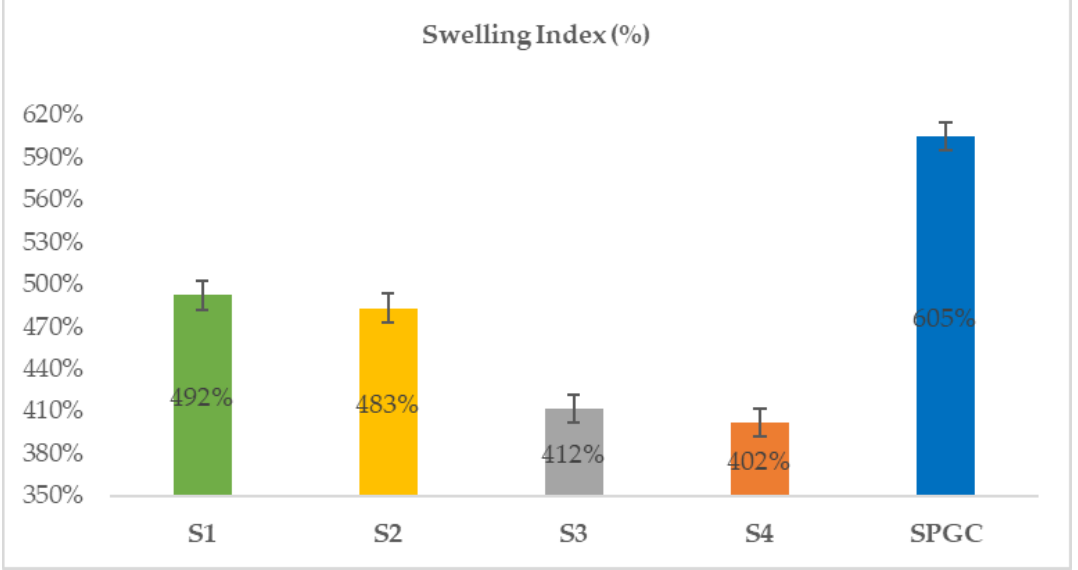
Figure 5. The outcomes of the nZnO particles on the starch-based films’ (S1–S4) swelling index compared to the SPGC sample without nZnO.